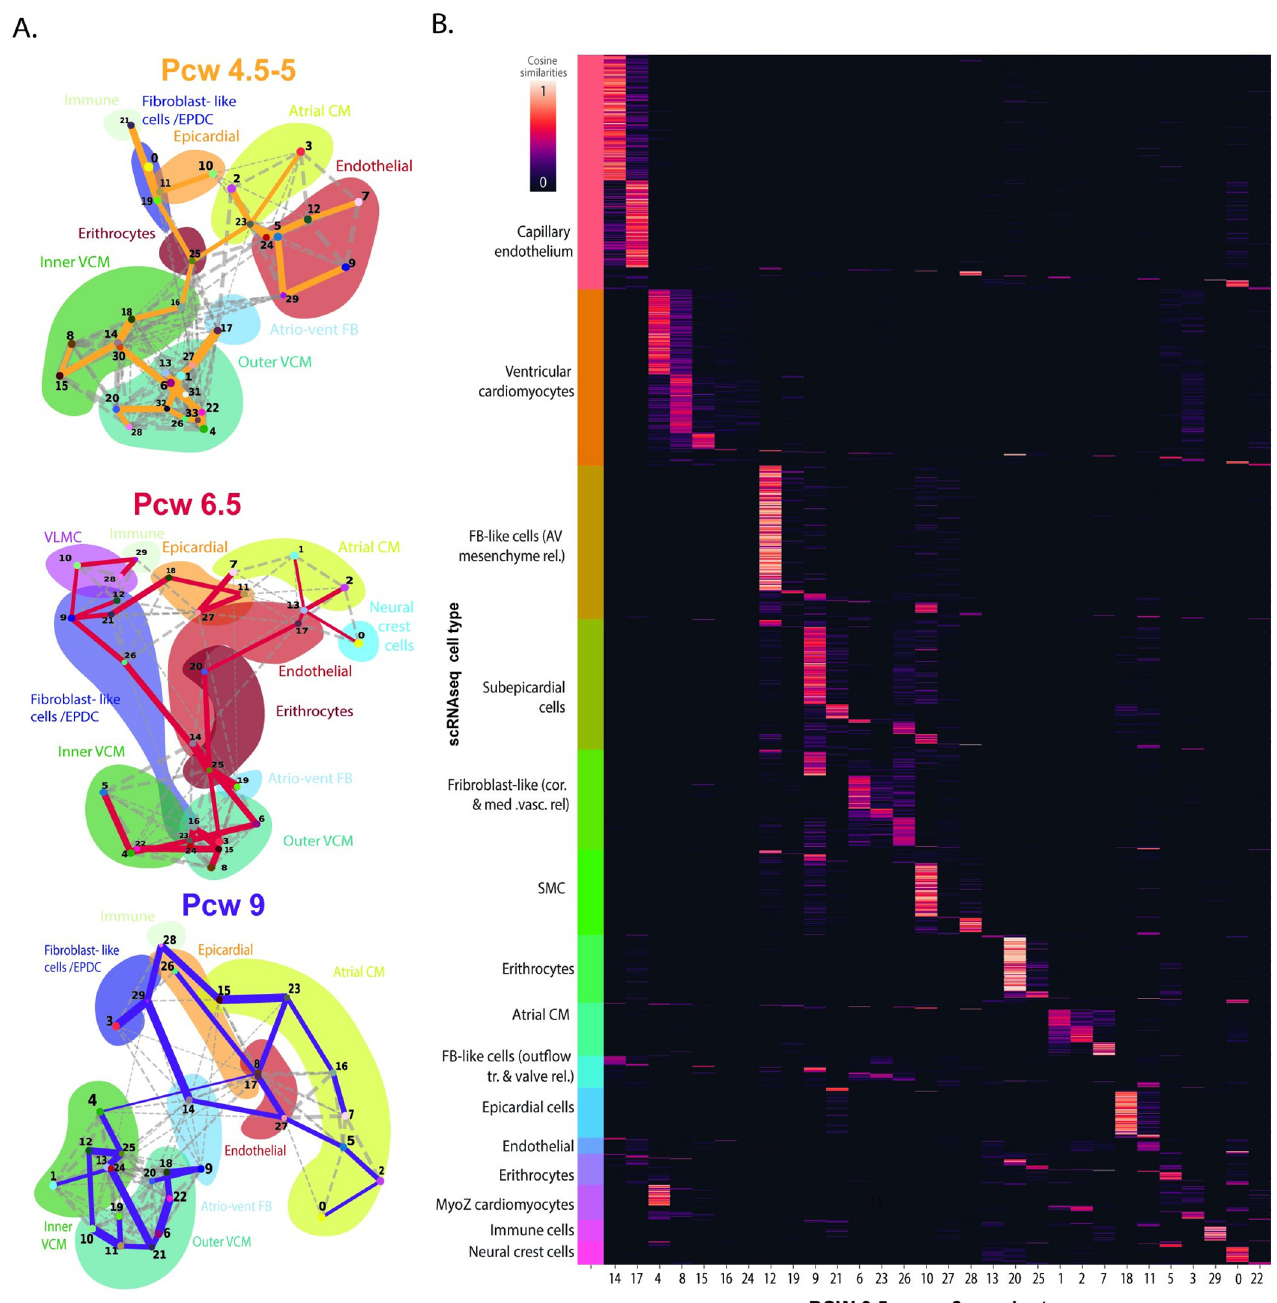
Fig 2. Analysis of individual developmental stages and correspondence with single cell data. A. PAGA plots of the clusters found in each time point specific analysis. Clusters from each time point are represented in a PAGA plot, including 4.5–5 PCW (top), 6.5 PCW (middle) and 9 PCW (bottom). Background colors represent the main cell types found in the dataset. B. Heatmap representing correspondence in terms of cosine similarities between scRNA-seq data and spage2vec clusters from PCW 6.5 (Materials and Methods), normalized by row, therefore ranging from 0 to 1. Cells from scRNA-seq dataset (rows) are sorted based on their cell type in order to facilitate the